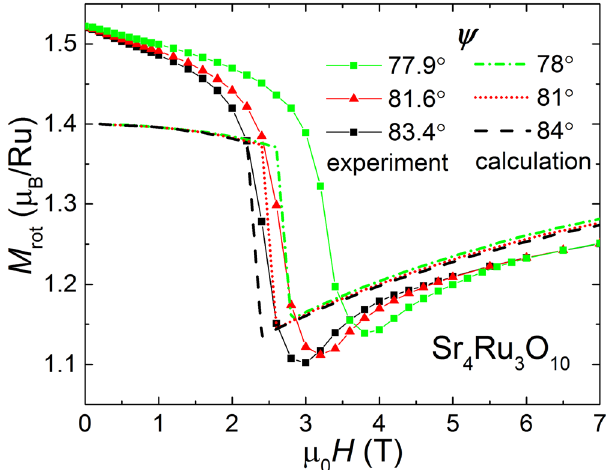
Figure 6. The experimental magnetization moduli M rot for 3 different angles ψ (symbols) measured at 1.8 K in decreasing magnetic field are compared with numerical simulations (broken lines) of the general anisotropy model as described by Eq. (1).